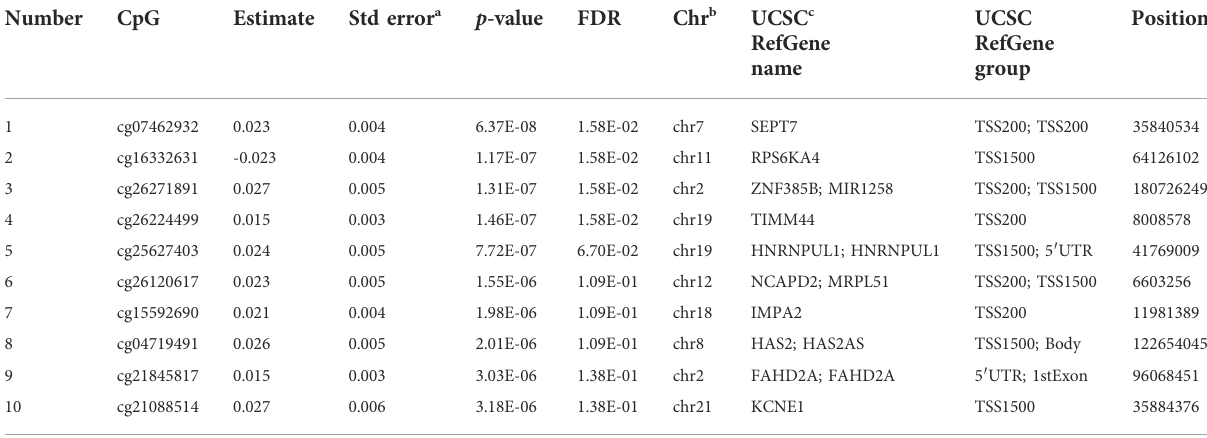
TABLE 3 Ten strongest associations between DNA methylation site (CpGs) and BMI. The model is adjusted for age, sex, CD4T, Bcell, CD8T, Gran, Mono, NK as fi xed effect and chip and position bead array as random effect.